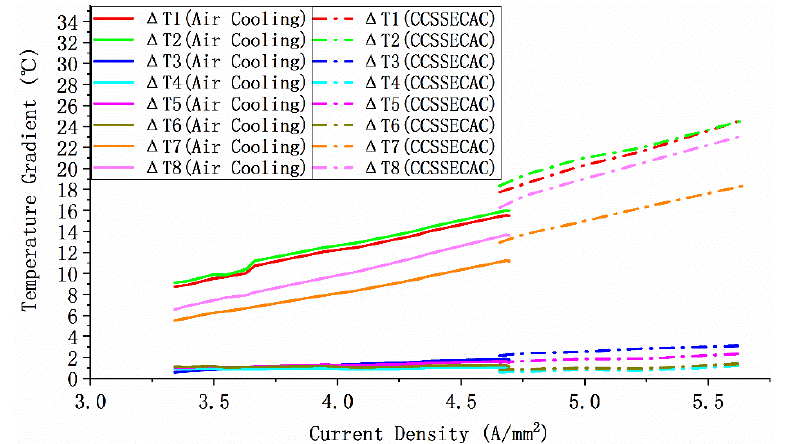
Figure 7. The temperature gradients at different positions. Table 2. Definitions of the labels of the curves in Figure 7.